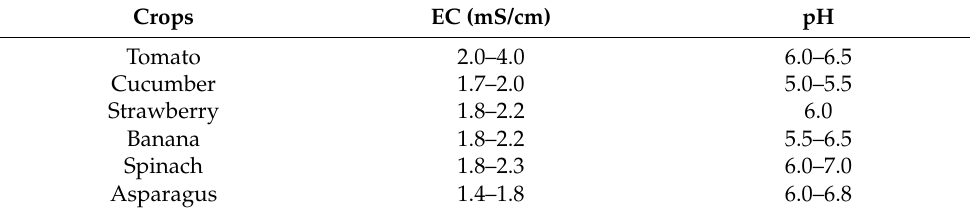
Table 1. Crops’ ideal pH and electrical conductivity values [21].